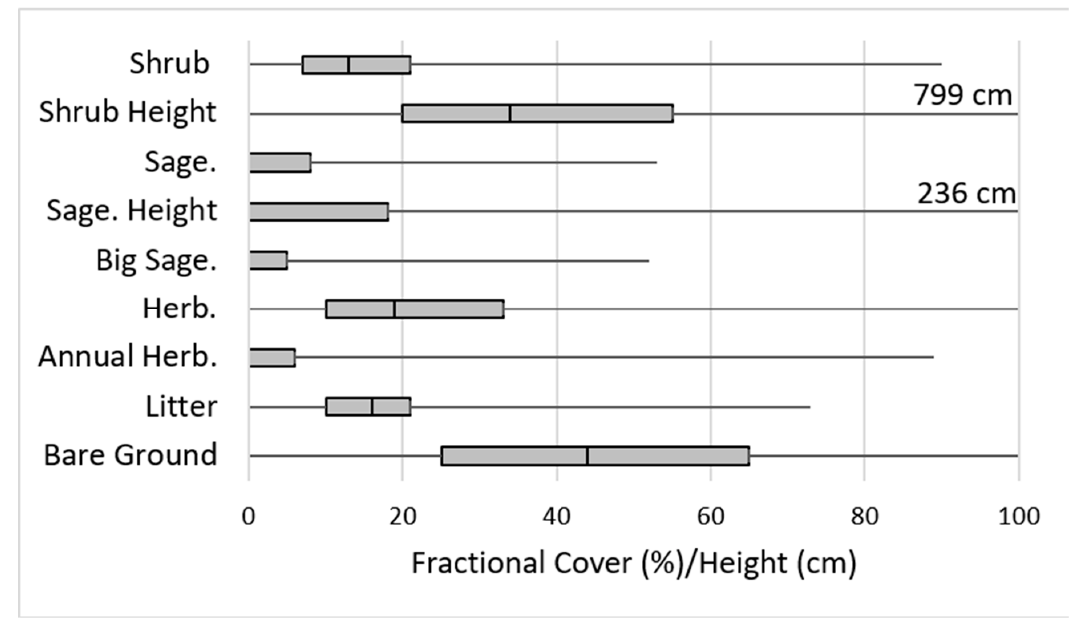
Figure 5. Box plots of component cover (%)/height (cm). Left box corresponds with the 1 st quartile through median, right box is the median through 3 rd quartile. Left and right whiskers are minimum and maximum, respectively. Maximum values of shrub and sagebrush height are